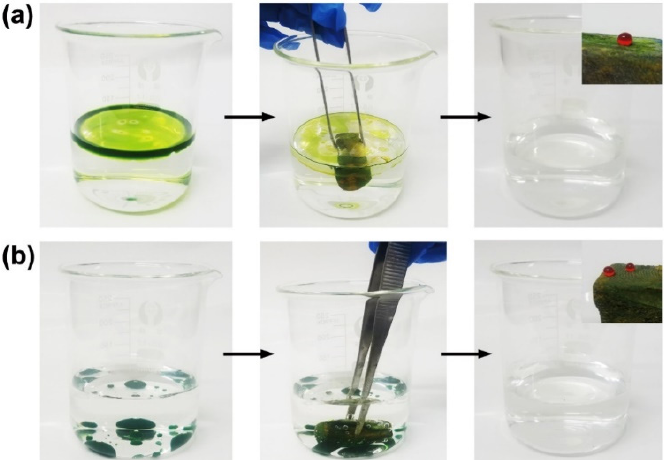
Figure 6. Photographs of the oil–water separation tests. ( a ) The absorption of the gasoline (dyed with chrome oxide green) from the gasoline–water mixture, ( b ) the absorption of chloroform (dyed with chrome oxide green) from the chloroform–water mixture.